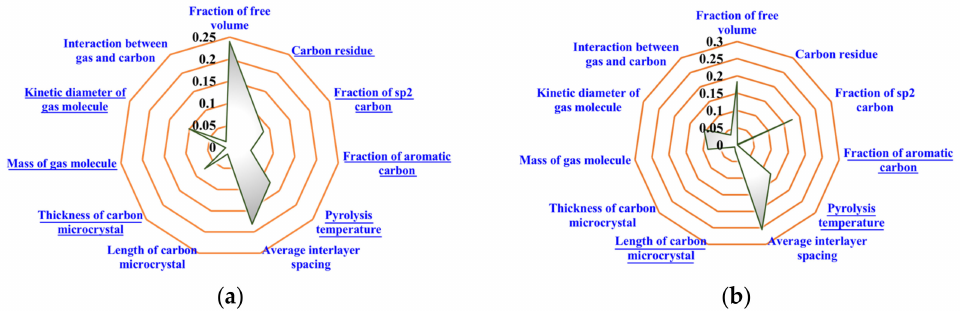
Figure 7. The normalized weights of the influencing factors on gas permeability regressed by SVR model with ( a ) RBF kernel; ( b ) quartic polynomial kernel (factors with underline are